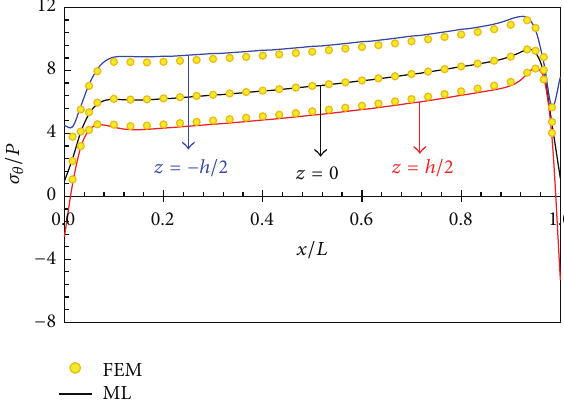
Figure 6: Radial stress distribution in middle layer.